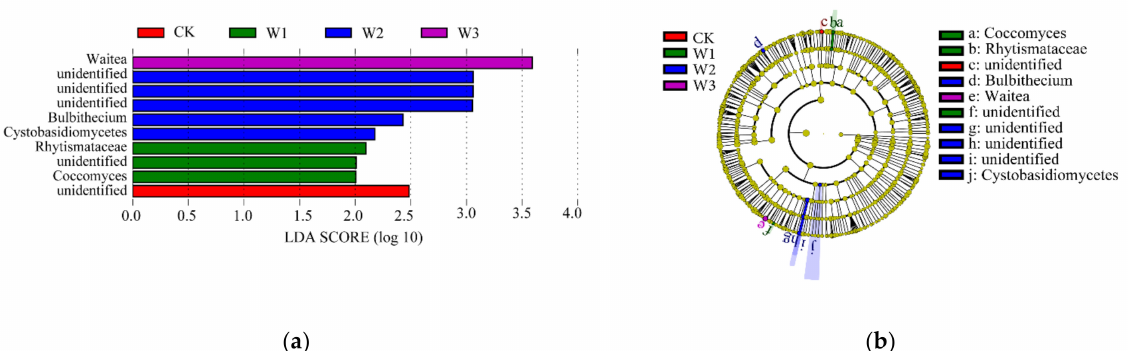
Figure 9. Fungus analysis of difference between groups. Note: ( a )–Differential species score chart; different colors indicate distinct groups; the bars indicate the relative abundance in the groups. ( b )–Annotated branch diagram of different species; distinct colors represent different groups, red nodes represent significantly different species with relatively high abundance, and green nodes repre- sent relatively high differences in abundance. Significant species: the yellow nodes represent species with no significant difference between groups. The diameter of the node is proportional to the relative abundance. Each layer of nodes represents phylum/class/order/family/genus from the inside to the outside. Annotations of the layer species labels indicate the phylum/class/order/family/genus from the inside to the outside; the species names represented by the alphabets in the figure are shown in the legend on the